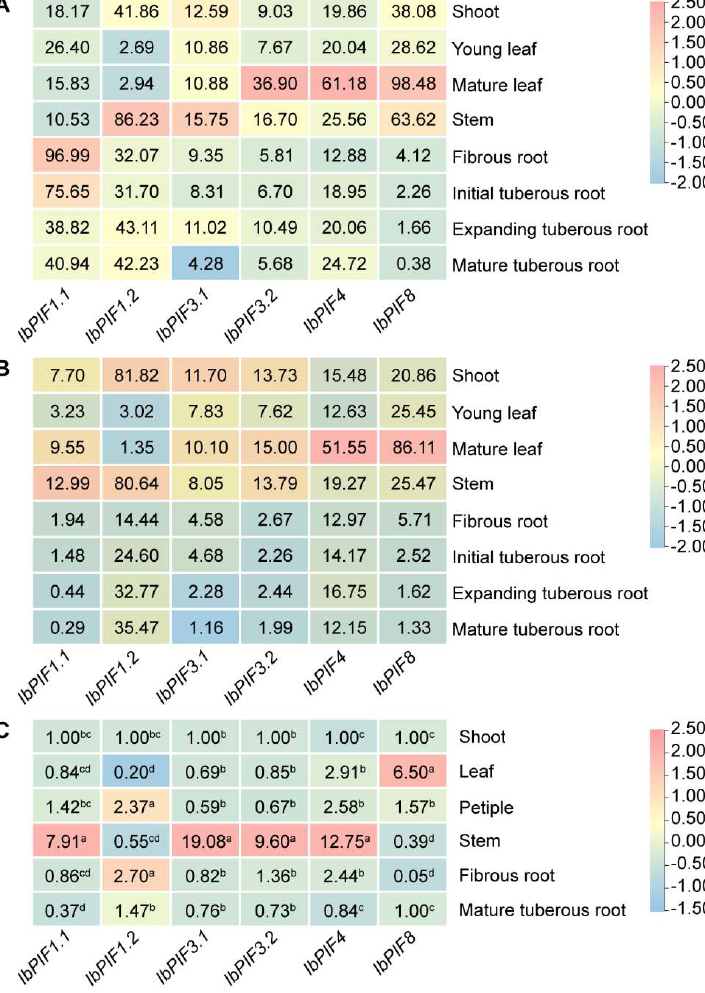
Figure 6. Gene expression patterns of IbPIFs in different tissues (shoot, young leaf, mature leaf, stem, fibrous root, initial tuberous root, expanding tuberous root, and mature tuberous root) of ( A ) Yan252 and ( B ) Xuzi3, as determined by RNA-seq. Log 2 (FPKM + 1) is shown in the boxes. ( C ) Gene expression patterns of IbPIFs in shoot, petiole, leaf, stem, fibrous root, and mature tuberous root of I. batatas. The values were determined by qRT-PCR from three biological replicates consisting of pools of three plants, and the results were analyzed using the comparative C T method. The expression at 0 h in each treatment was considered “1”. The fold change is shown in the boxes. Different lowercase letters indicate a significant difference of each IbPIFs at p < 0.05 based on Student’s t –test. To verify the RNA-seq results, qRT-PCR was conducted to measure the expression levels of IbPIF genes in six tissues (i.e., shoot, leaf, petiole, stem, fibrous root, and mature tuberous root). The qRT-PCR results showed that IbPIF1.2 , IbPIF3.1 , and IbPIF3.2 had lower expression in leaf, while IbPIF8 had higher expression in leaf, IbPIF1.1 and IbPIF3.1 had a gradually down-regulated trend during root development, and IbPIF4 was highly expressed in stem (Figure 6C). These results were roughly consistent with the RNA-seq analysis.